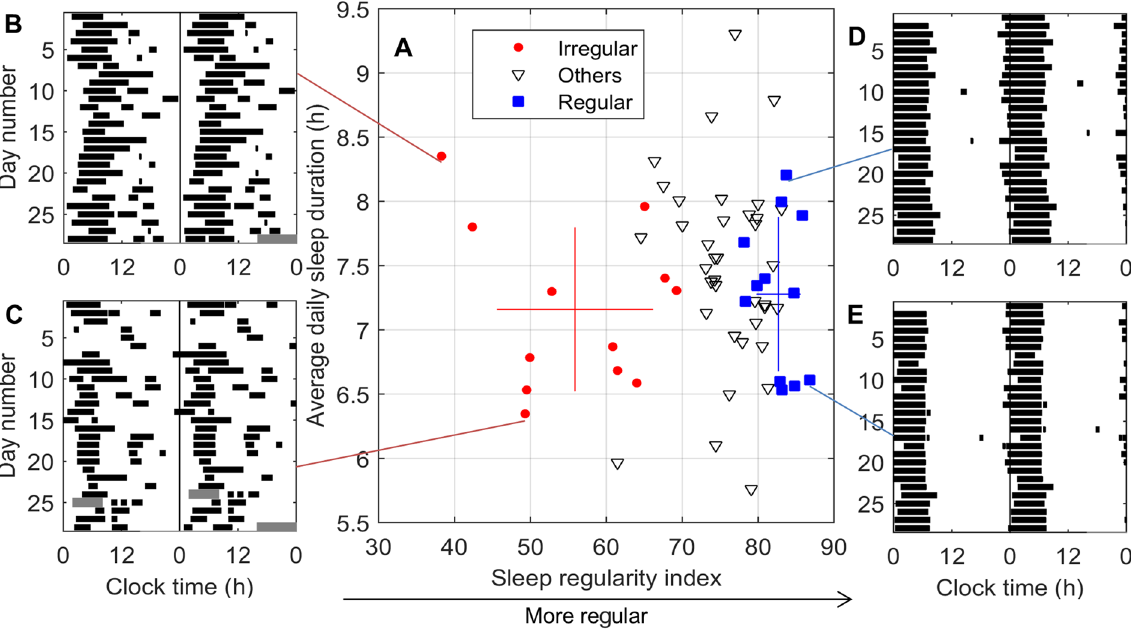
Figure 1. Two dimensions of sleep: duration and regularity. ( A ) Average daily sleep duration vs. sleep regularity index (SRI) for all participants ( n = 61) assessed across the whole study interval. Participants identified for the Irregular ( n = 12) and Regular ( n = 12) groups at the study mid-point are red circles and blue squares, respectively. Other individuals are white triangles. As explained in the Methods, the SRI values differed slightly by end of study, so those identified as most extreme at the study midpoint did not necessarily remain most extreme at end of study; however, the differences between Regular and Irregular groups remained highly significant (see Results). Error bars indicate mean and standard deviation for Regular and Irregular groups in both SRI and sleep duration. Sleep patterns for four participants collected using daily diaries are shown using double-plotted raster diagrams, where black bars indicate episodes of sleep and gray bars indicate missing data. Four examples are displayed: ( B ) an Irregular long sleeper, ( C ) an Irregular short sleeper, ( D ) a Regular long sleeper, and ( E ) a Regular short sleeper.